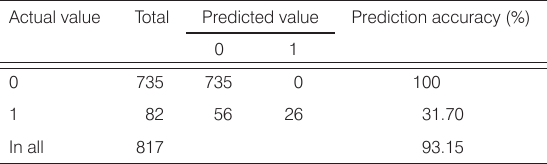
Table 4. Confusion matrix from prediction results of GDM incidence in the F2